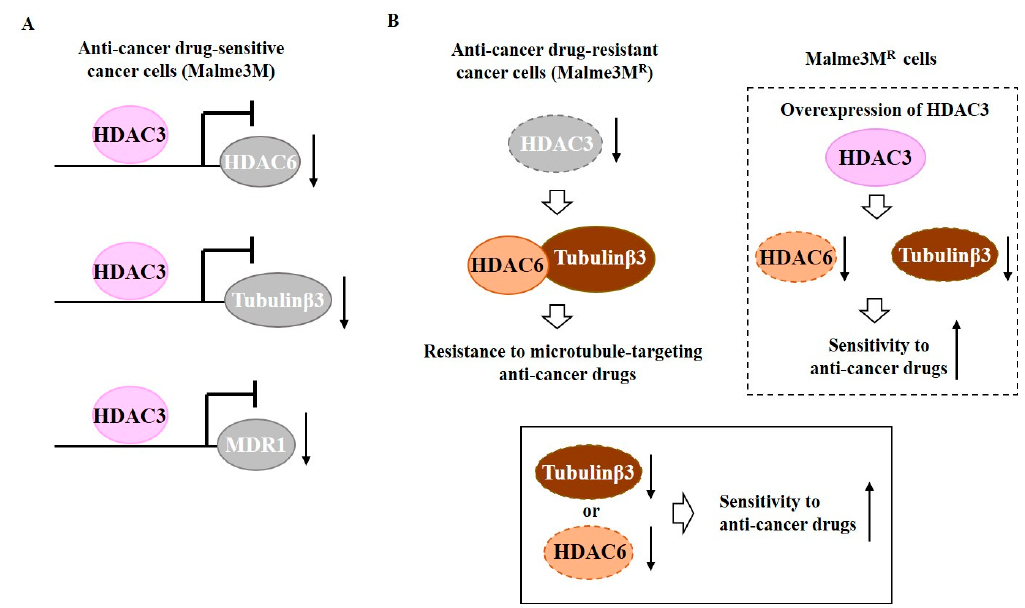
Figure 1. Tubulin β 3 serves as a downstream target of histone deacetylase 3 (HDAC3) and mediates resistance to microtubule-targeting drugs. ( A ) In anti-cancer drug-sensitive cancer cells, HDAC3 binds to the promoter sequences of histone deacetylase 6 (HDAC6), tubulin β 3, and MDR1. HDAC3 decreases expression levels of HDAC6, tubulin β 3, and MDR1. ( B ) In anti-cancer drug-resistant melanoma cells (Malme3M R cells), HDAC6 interacts with tubulin β 3. Down-regulation of HDAC3 induces interaction of HDAC6 with tubulin β 3. Down-regulation of tubulin β 3 or HDAC6 enhances sensitivity of Malme3M R cells to anti-cancer drugs. The T-bar arrows denote inhibition of transcription. The ↑ rrows denotes increased expression level and ↓ arrows denotes decreased expression